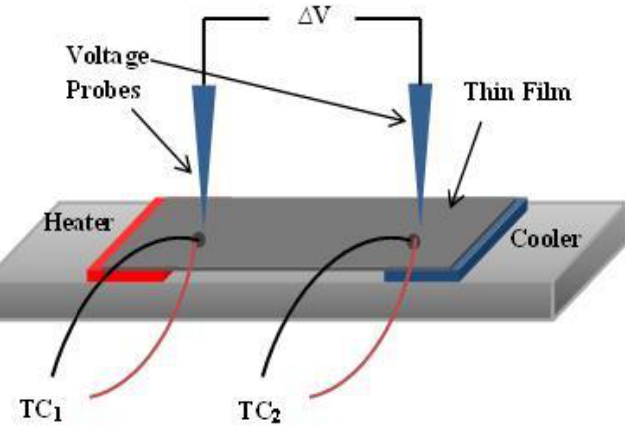
Figure 2. Schematic diagram of homemade setup for Seebeck coefficient measurement.